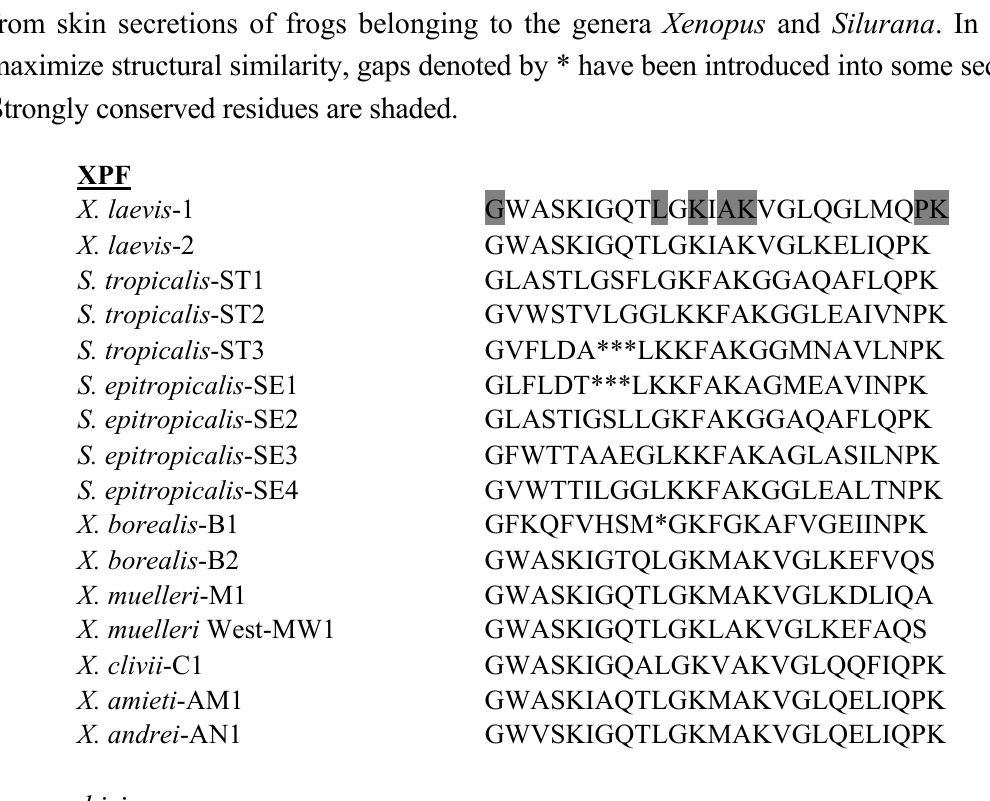
Figure 4. Primary structures of the xenopsin precursor fragment (XPF) peptides isolated from skin secretions of frogs belonging to the genera Xenopus and Silurana . In order to maximize structural similarity, gaps denoted by * have been introduced into some sequences. Strongly conserved residues are